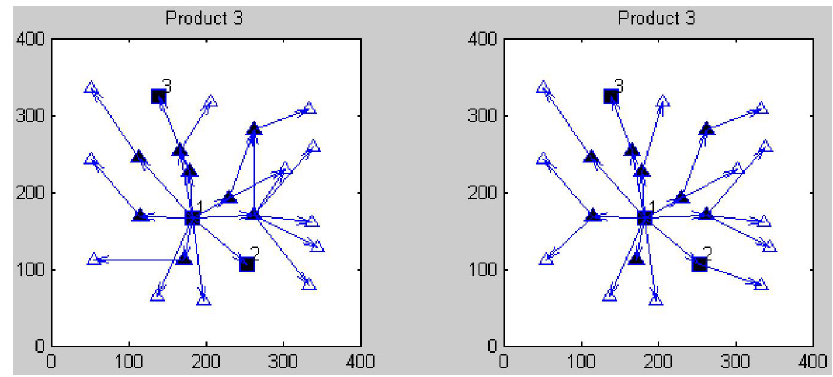
Fig. 7. Transshipment paths (product 3)